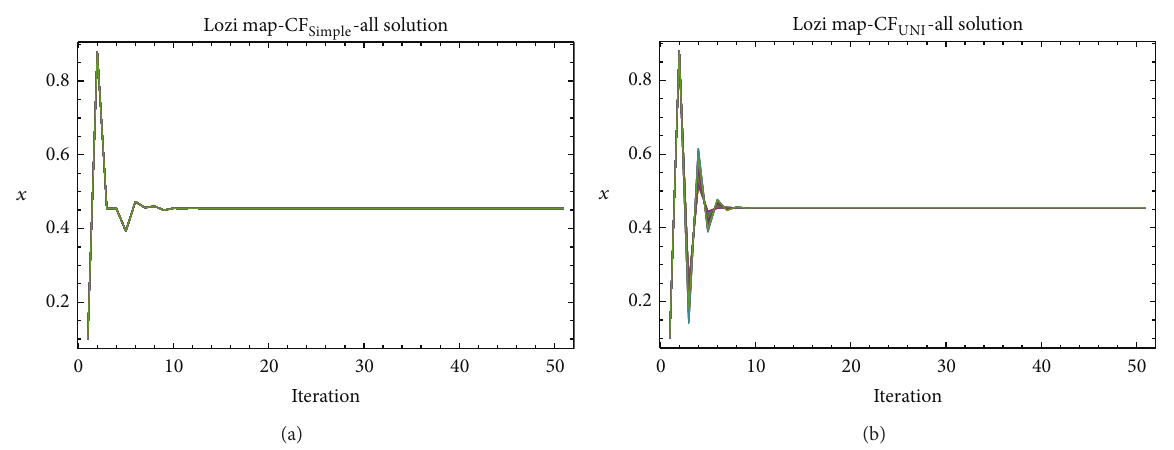
Figure 16: Simulation of the all 50 independent runs of EA, ChaosDE and Lozi map: case study 5, CF Simple (a); case study 6, CF